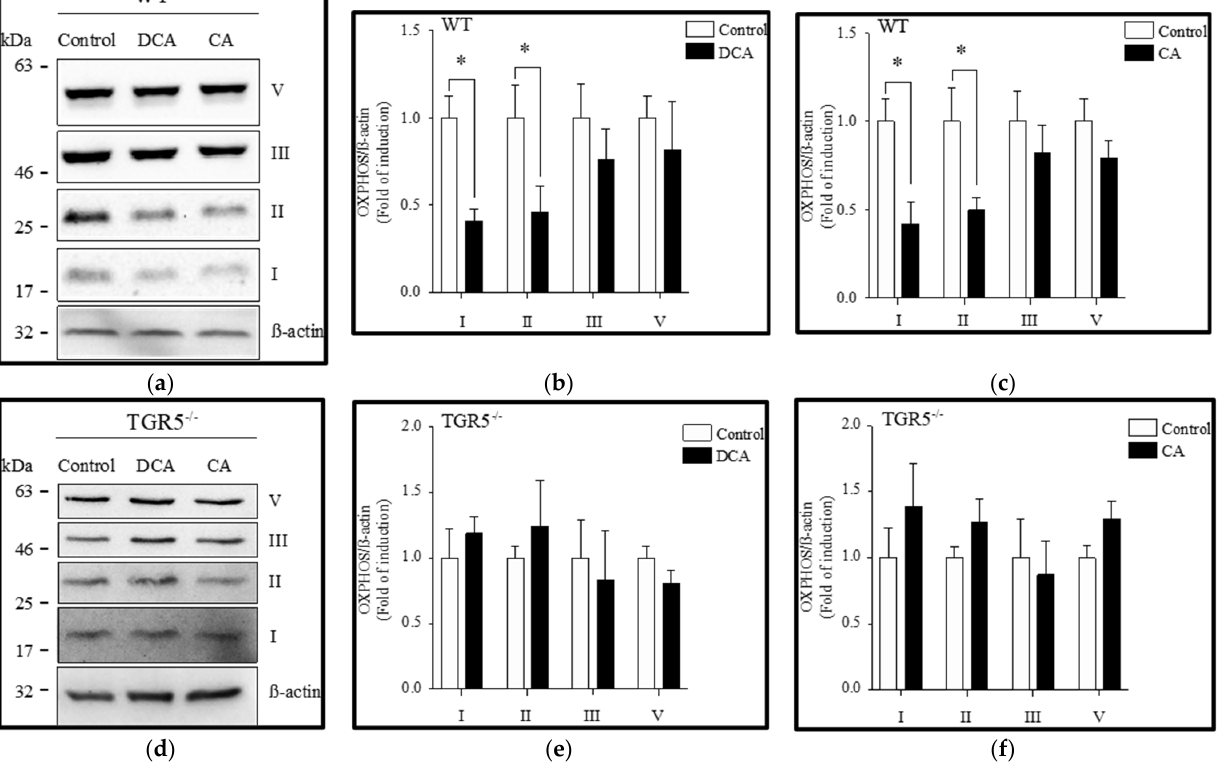
Figure 5. Deoxycholic acid (DCA) and cholic acid (CA) decrease oxidative phosphorylation (OXPHOS) complexes I and II from mitochondria in muscle fiber through a TGR5-dependent mechanism. Skeletal muscle fibers from WT and TGR5 − / − mice were incubated with DCA or CA for 72 h. Protein levels of mitochondrial complexes I, II, III, and V were detected by Western blot analysis.